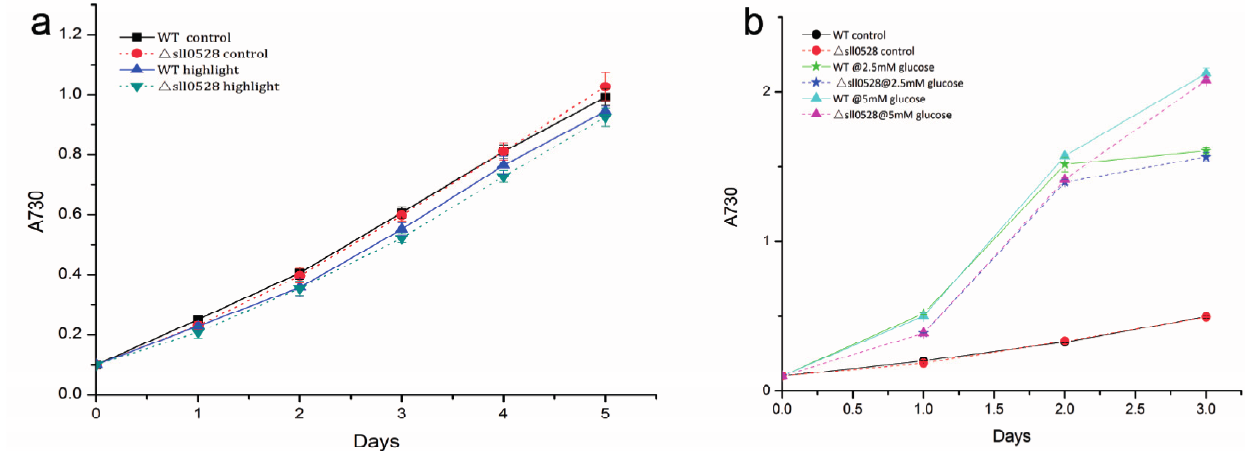
Figure 6. ( a ) Growth curve of wild type (WT) and sll0528 mutant ( Δ sll0528 ) in continuous light of control (30 μ mol·m − 2 ·s − 1 ) and high light (150 μ mol·m − 2 ·s − 1